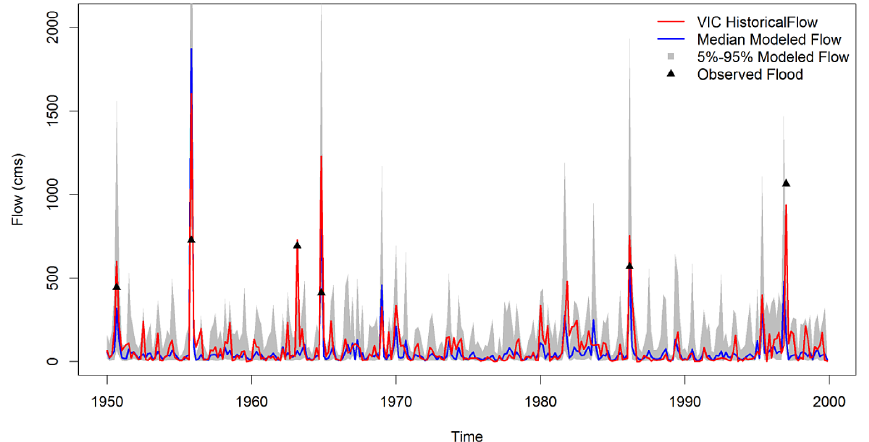
Figure 4. VIC-simulated 1-day flood maximums for November through April 1950 to 1999 (red lines) compared with the historical GEV distributions (blue line is median and grey shading is the 5th to 95th percentile range) and the six observed flow